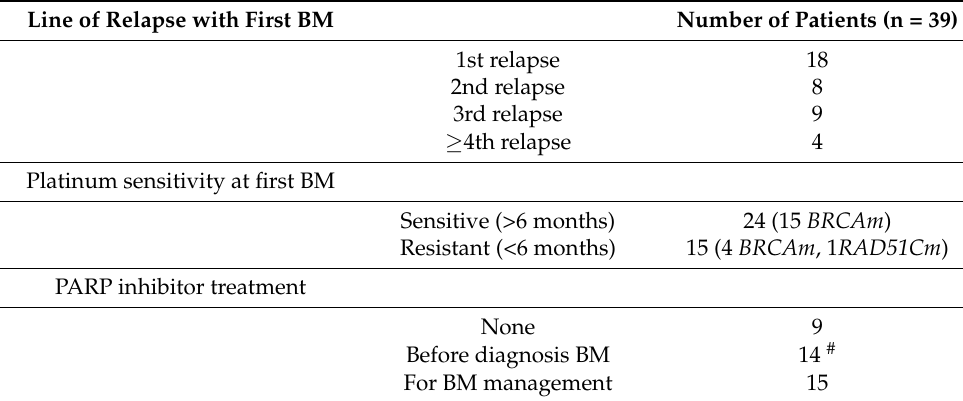
Table 2. Details of relapse with BM and treatments delivered.